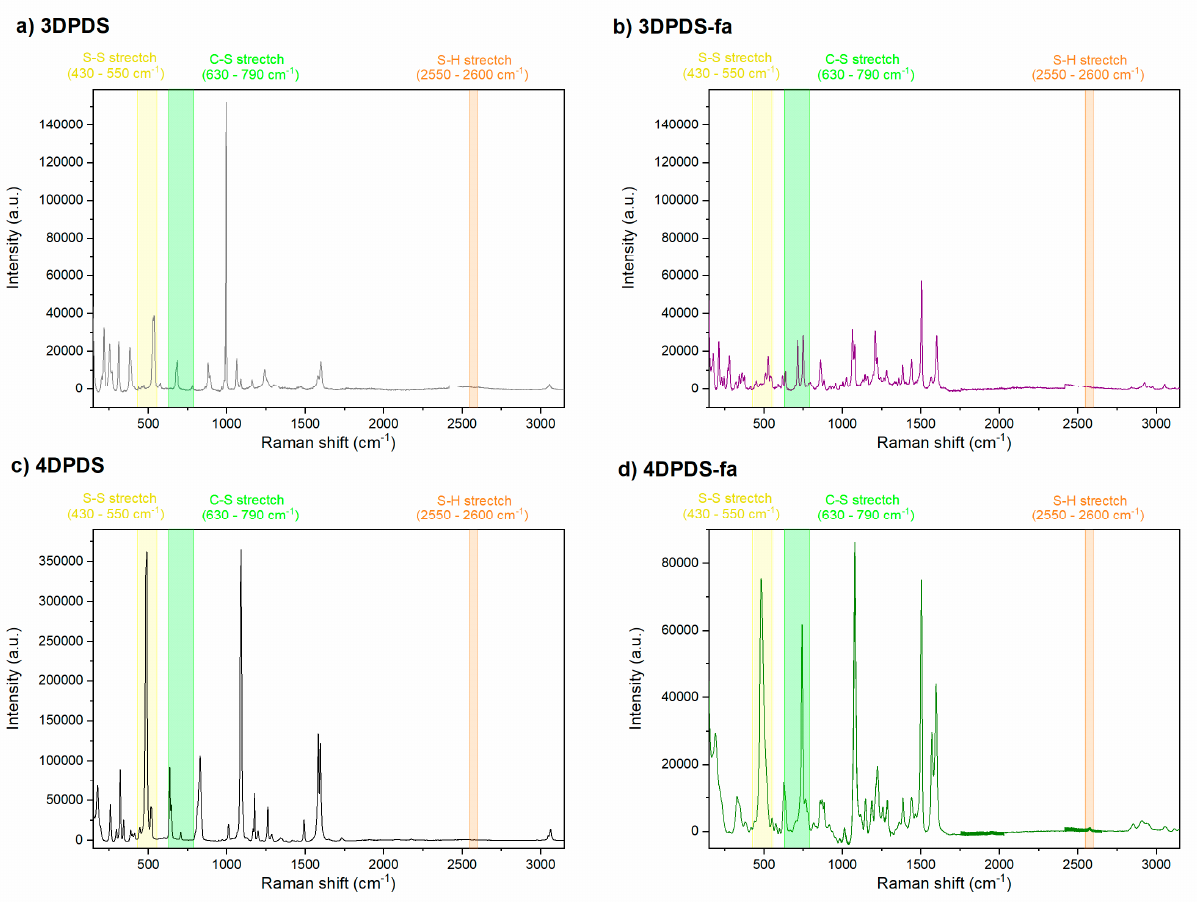
Figure A8. FTIR spectra of 4DPDS-fa, poly(4DPDS-fa) after curing at 170 °C for 1 h, and poly(4DPDS-fa) after curing at 170 °C for 1h and post-curing at 190 °C for 1h and 210 °C for 1 h.